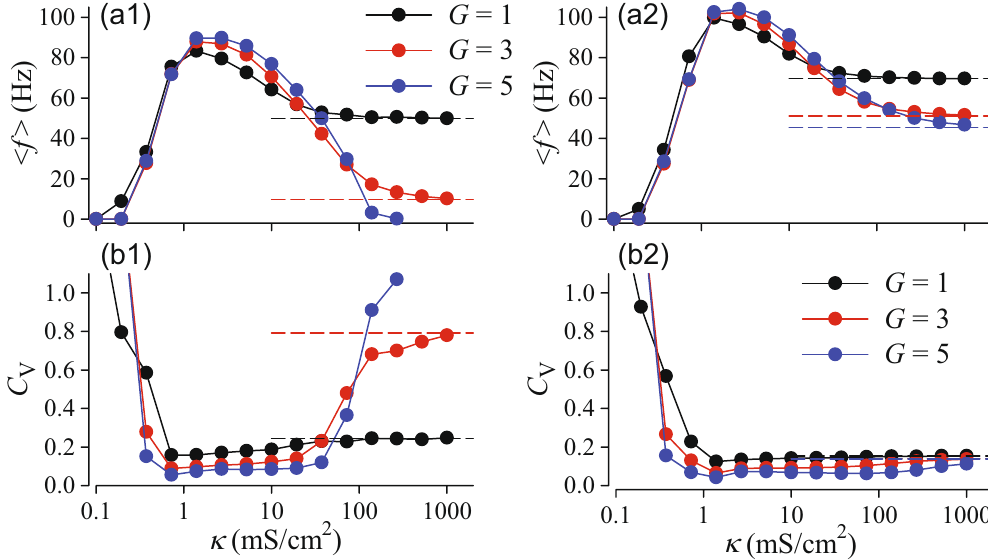
Figure 4. Mean firing rate (a1, a2) and coefficient of variation of interspike intervals (b1, b2) of the central node versus coupling strength for tree networks of HH nodes with d = 2 branching for the indicated numbers of generations, G . Left panels (a1, b1) correspond to the excitable regime with the constant current I = 35 μ A/cm 2 ; right panels (a2, b2) refer to the oscillatory regime with I = 60 μ A/cm 2 . The noise intensity is D = 500 ( μ A/cm 2 ) 2 ms. Horizontal dashed lines indicate the theoretical strong coupling limits for an effective node with scaled input current and noise intensity according to Eqs (22) and (23),